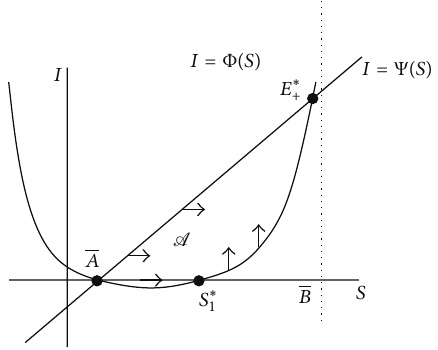
Figure 2: The invariant region A = {(𝑆,𝐼); Φ(𝑆) ≤ 𝑆 ≤ Ψ(𝑆), 0 ≤ 𝐼} mentioned in the proof of Proposition